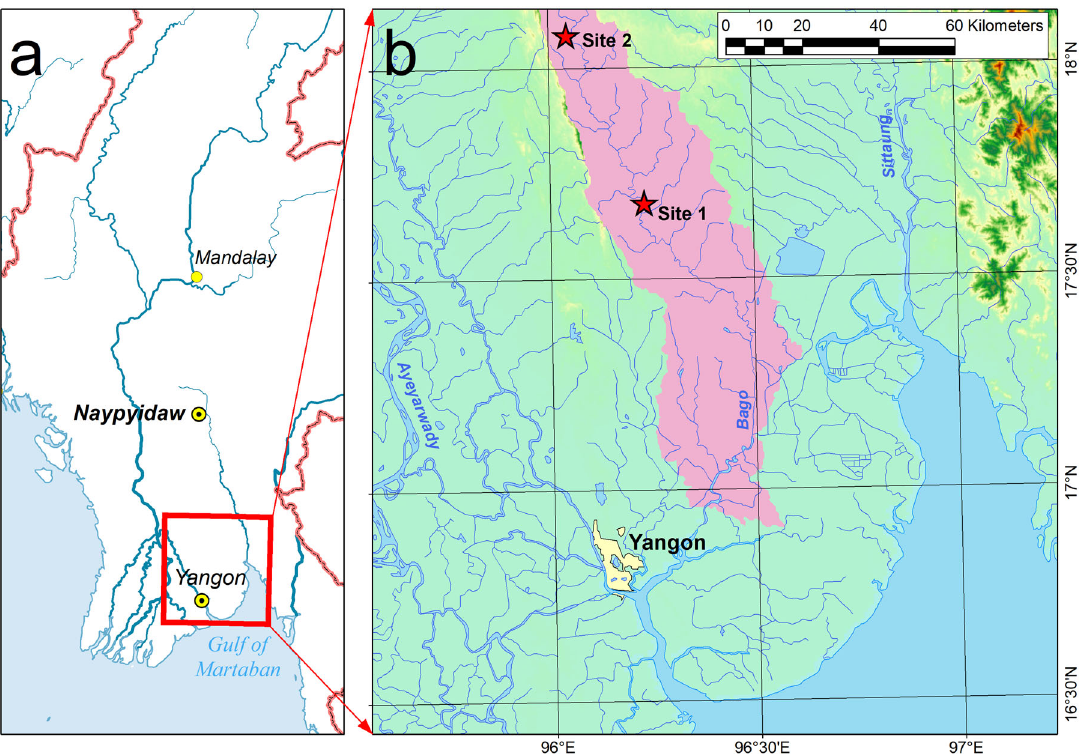
Fig. 1 Study area and sampling localities. a Map of Myanmar with location of the study area. b Map of the Bago River basin (light red fi lling). The red stars indicate freshwater macrobioerosion sites. The maps were created using ESRI ArcGIS 10 software (https://www.esri.com/arcgis). The topographic base of the maps was created with Natural Earth Free Vector and Raster Map Data (https://www.naturalearthdata.com), Global Self-consistent Hierarchical High-resolution Geography, GSHHG v2.3.7 (https://www.soest.hawaii.edu/wessel/gshhg), HydroSHEDS (https://www.hydrosheds.org) 97 , The General Bathymetric Chart of the Oceans, GEBCO (https://www.gebco.net), and Vector Map (VMap) Level 0 (http://gis-lab.info/qa/vmap0-eng.html). (Maps: Mikhail Y.